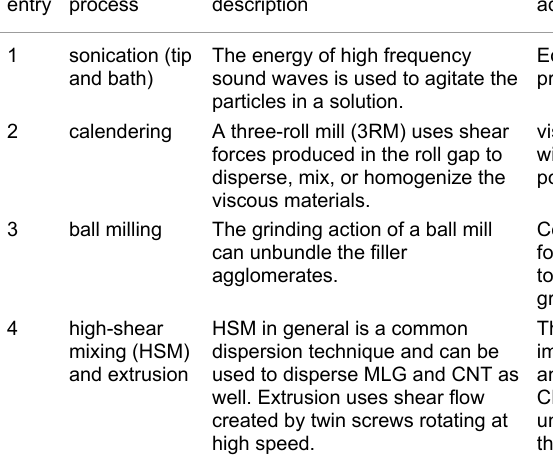
Table 1: Various mechanical dispersion processes. entry